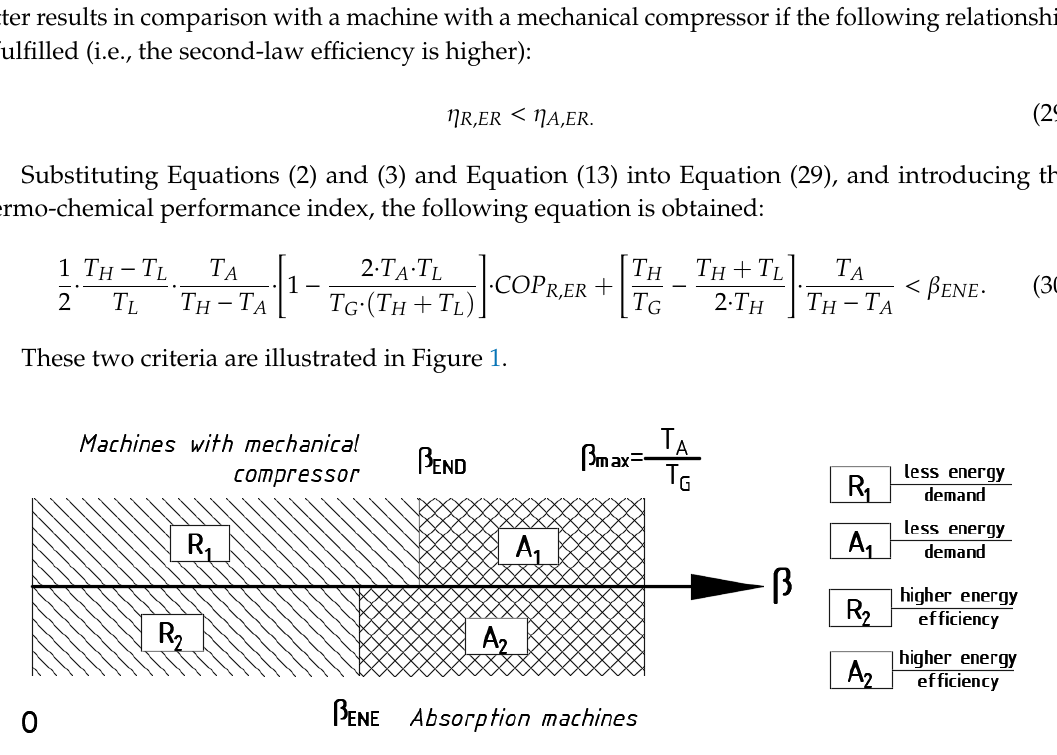
Figure 1. Energy demand and energy efficiency depending on the thermo-chemical performance index.